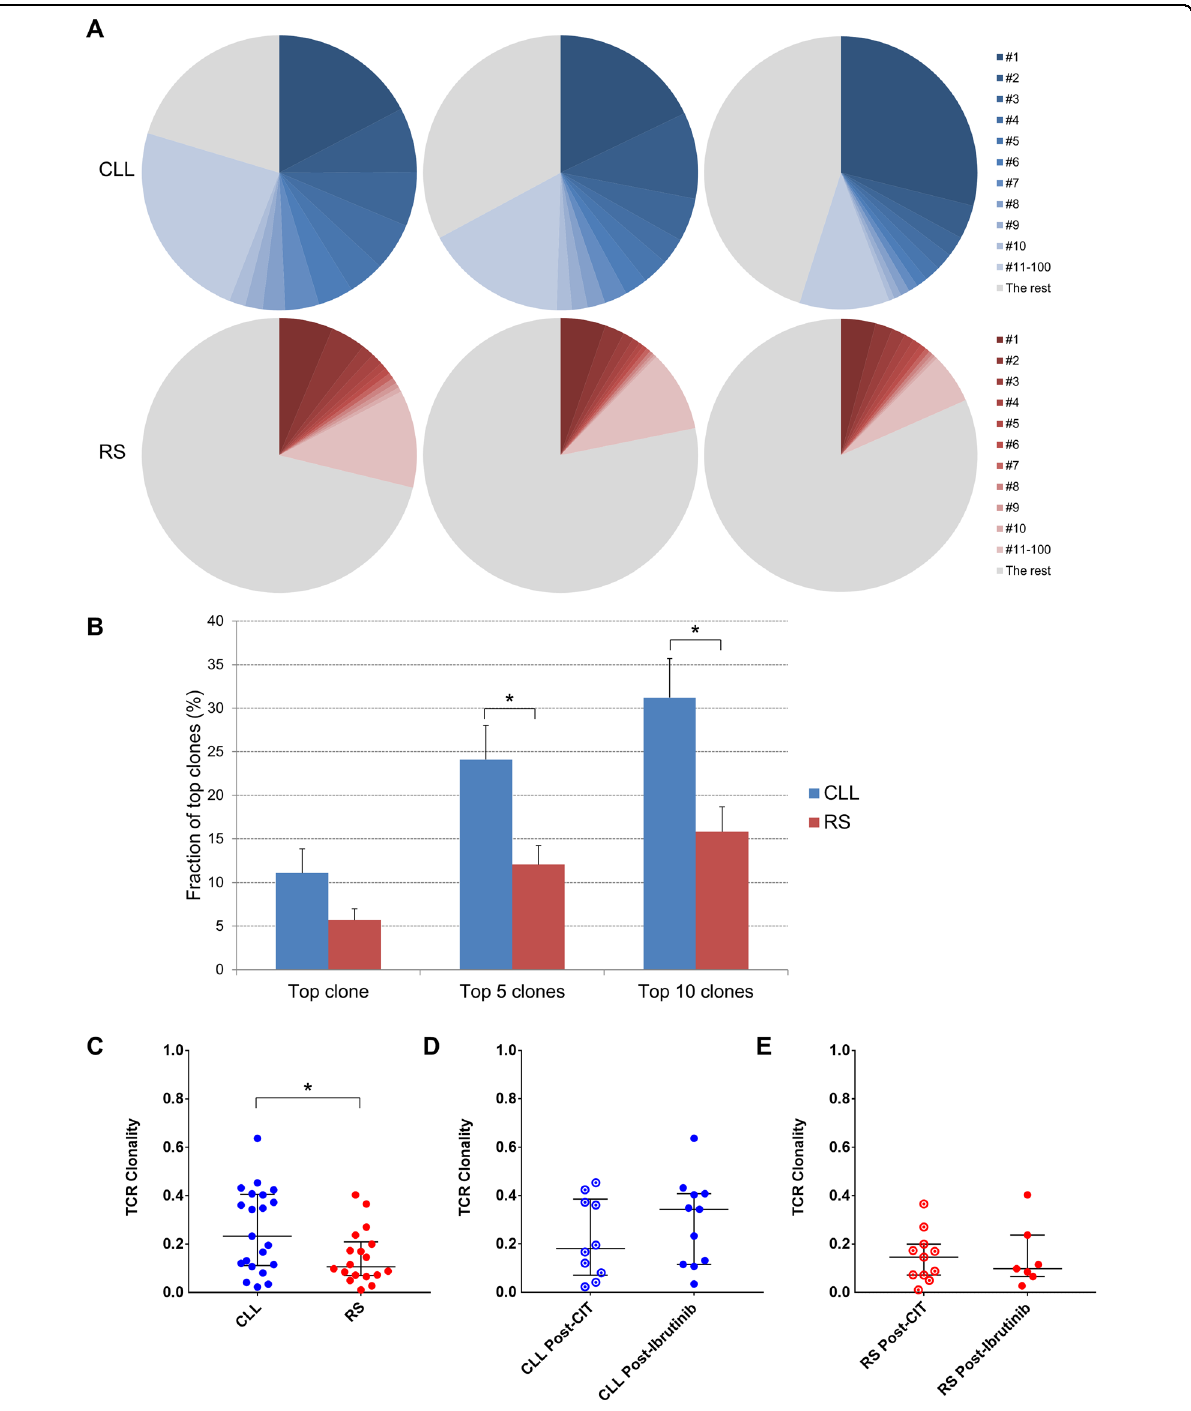
Fig. 2 Peripheral blood TCR clonality in CLL and RS patients. A Fractions of top 10 and top 100 TCR clones in representative CLL ( n = 3, upper panel) and RS ( n = 3, lower panel) cases. B Quantitative comparison of top 1, top 5, and top 10 TCR clone fractions in CLL ( n = 21) and RS ( n = 18) cases. C TCR clonality in CLL vs. RS cases. D TCR clonality in post-CIT vs. post-ibrutinib CLL cases. E TCR clonality in post-CIT vs. post-ibrutinib RS cases. Asterisk (*) indicates P <